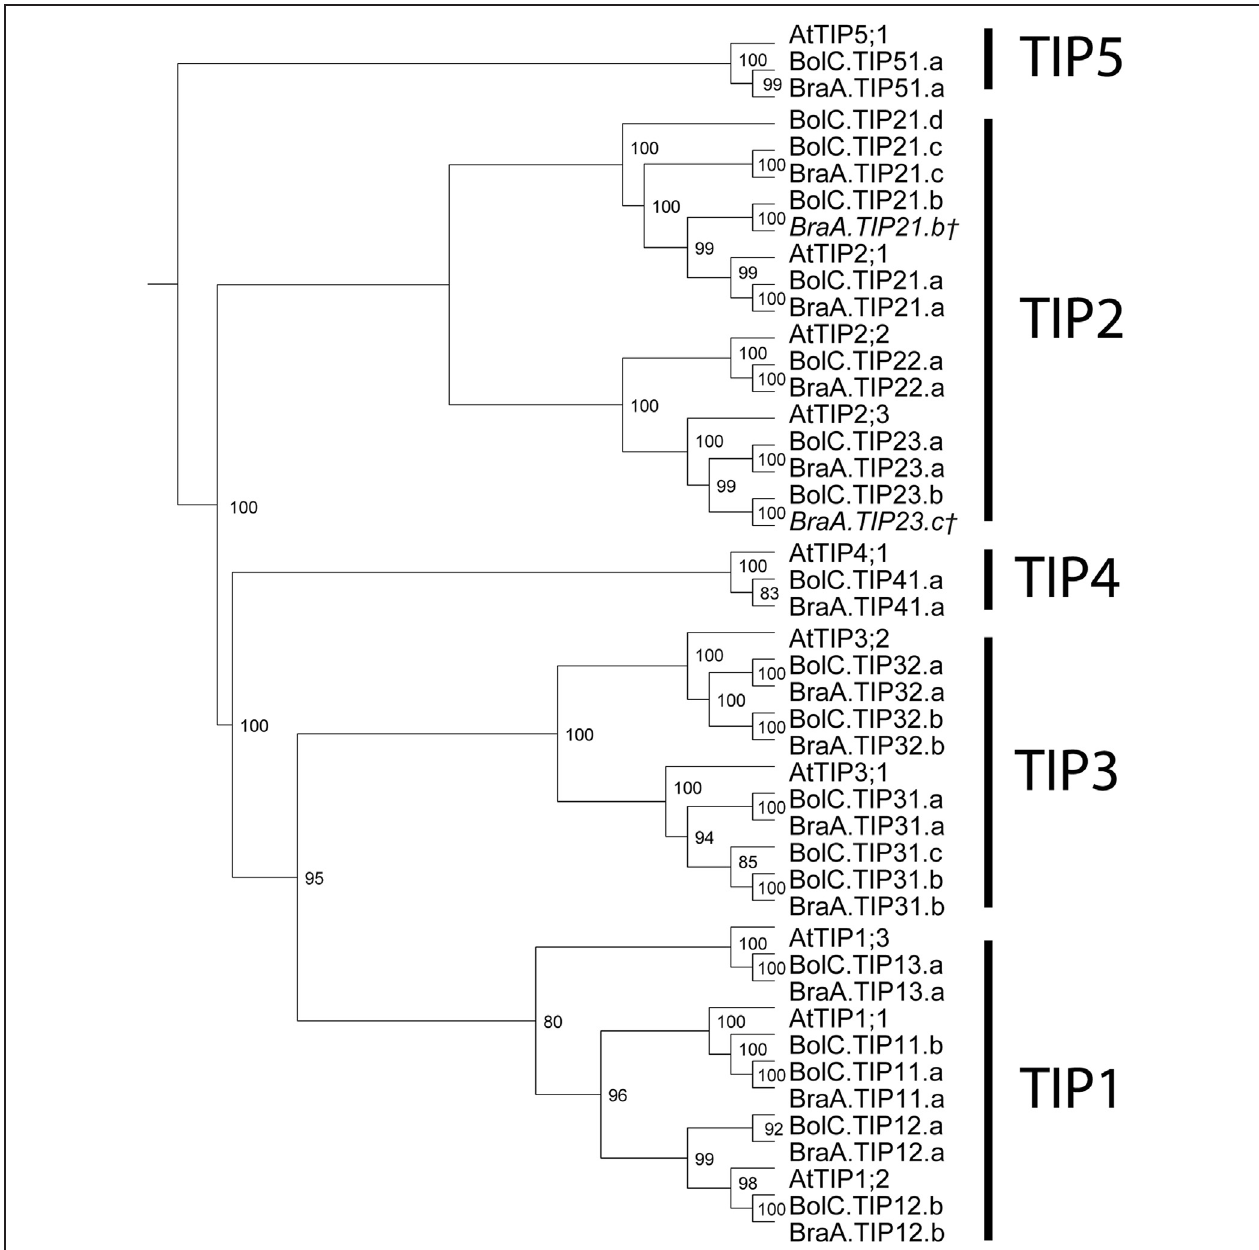
> 75%. Gene IDs which are written in italics and/or marked with a cross ( † ) do not encode for full-length AQPs due to mutations leading to frameshifts or stop codons in their